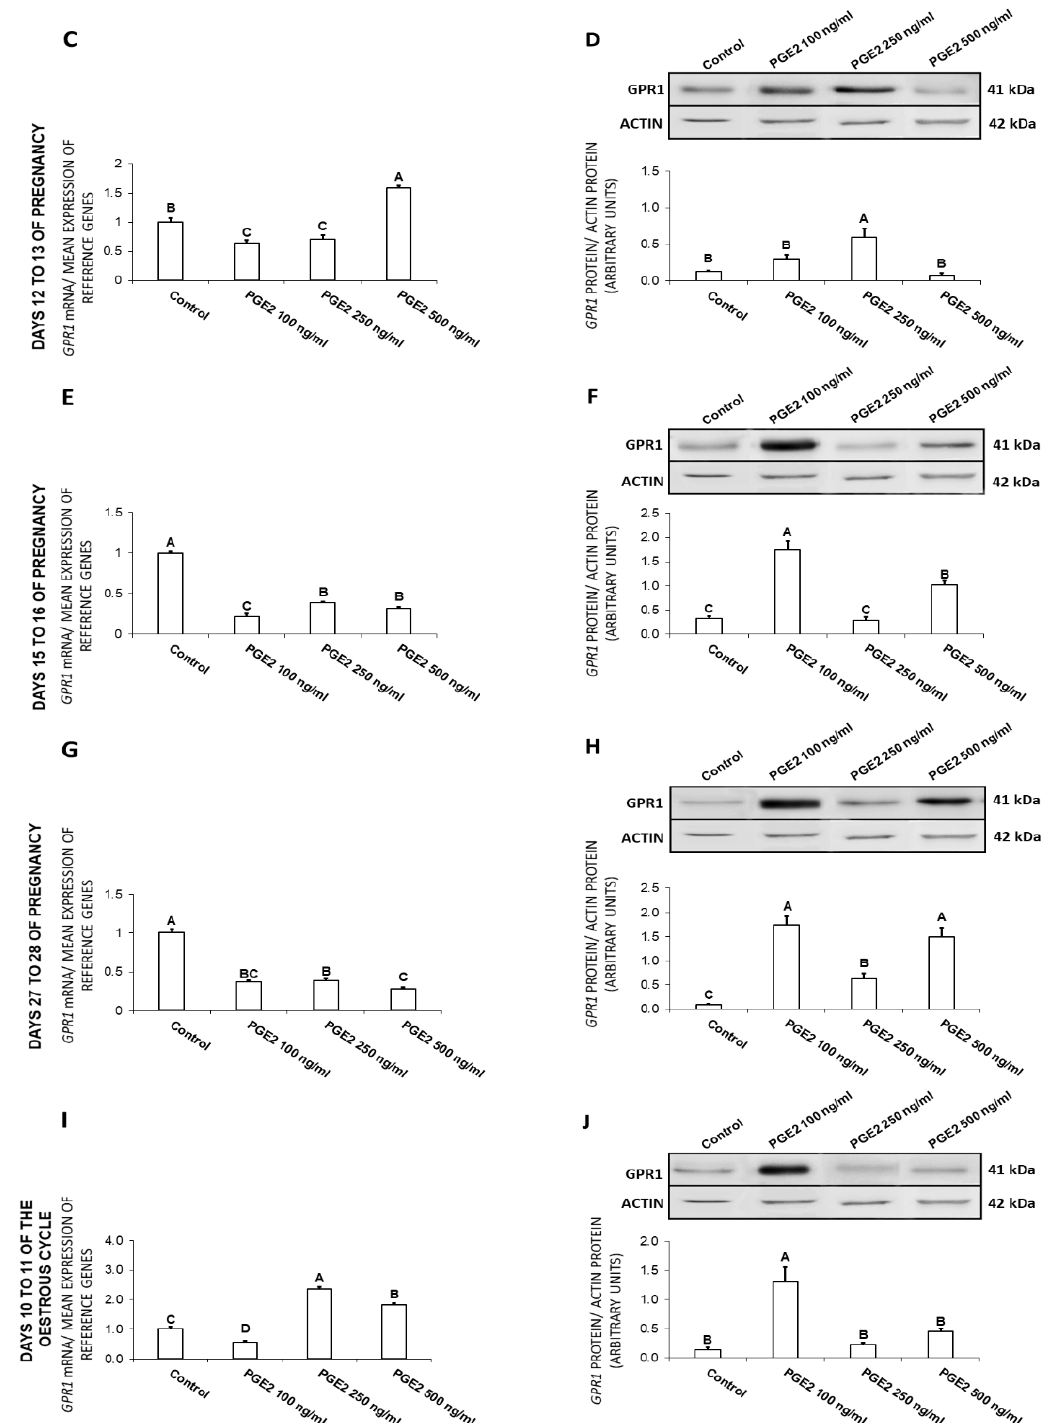
Figure 3 . The influence of prostaglandin E 2 (PGE 2 ; 100, 250, 500 ng/mL) on G protein-coupled receptor 1 (GPR1) mRNA ( A , C , E , G , I ) and protein ( B , D , F , H , J ) expression in the porcine endometrium on days 10 to 11, 12 to 13, 15 to 16, and 27 to 28 of the pregnancy, and on days 10 to 11 of the estrous cycle. The gene expression was determined by quantitative real-time PCR. The protein concentration was determined by the western blotting analysis; upper panels: Representative immunoblots; lower panels: Densitometric analysis of GPR1 protein relative to actin protein. Results are reported as the means ± S.E.M. ( n = 5). Bars with di ff erent superscripts di ff er ( p <